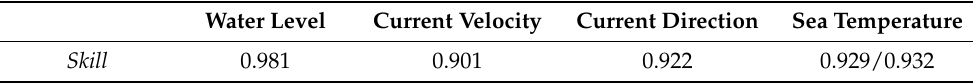
Figure 3. Verification of sea temperature in ( a ) T1 and ( b ) T2 (3–17 August 2019). Table 2. The Skill score of water level, current direction, current velocity and sea temperature.